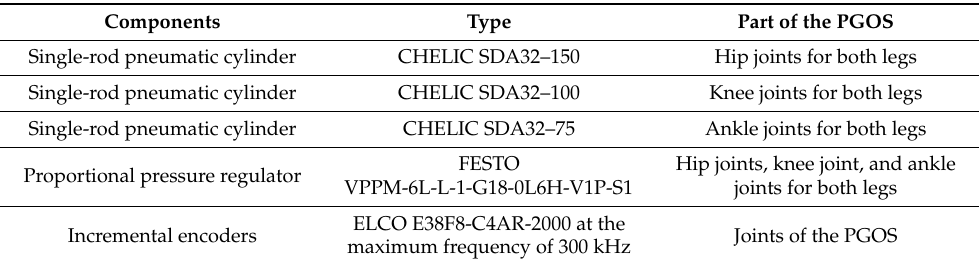
Table 1. Components of the PGOS.